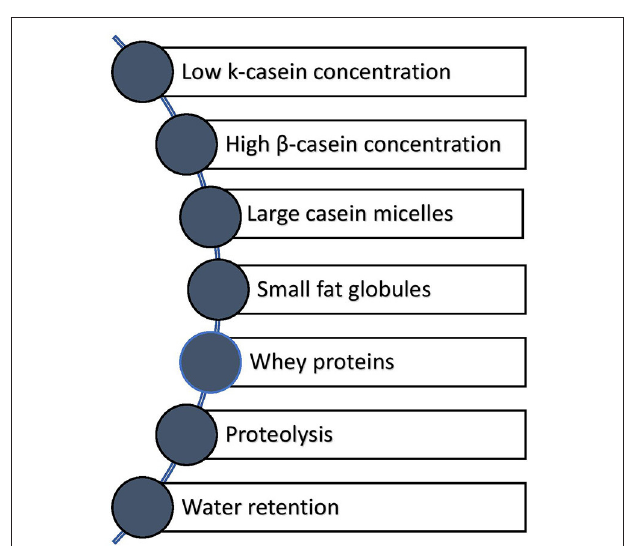
FIGURE 4 | Milk compositional factors that contribute to the soft texture of CM cheese.